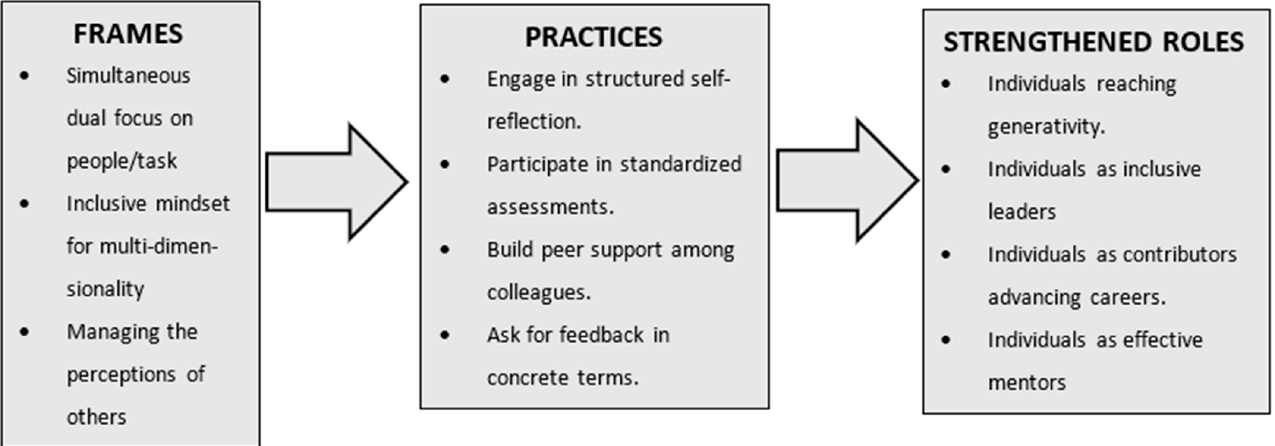
Figure 1. Frames, practices, and strengthened roles.